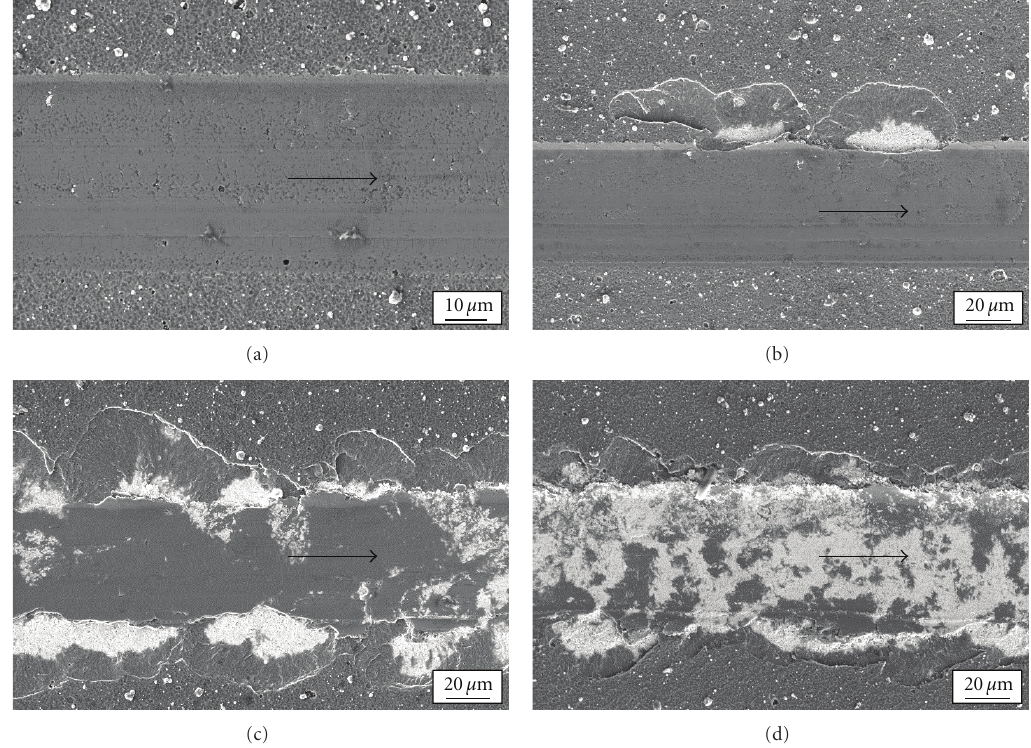
Figure 4: SEM micrographs illustrating the major coating failure mechanisms in the single-pass scratch test by using a diamond stylus with radius R = 50 μ m. (a) Plastic deformation and minor cracking (no coating material detached), (b) chipping (cohesive failure) in combination with local interfacial spalling (adhesive failure), (c) continuous interfacial spalling (adhesive failure), and (d) continuous interfacial spalling in combination with extensive coating fragmentation at normal loads above F N , C 2 for Ti 0 . 34 Al 0 . 66 N coating. The arrows indicate the scratching direction.